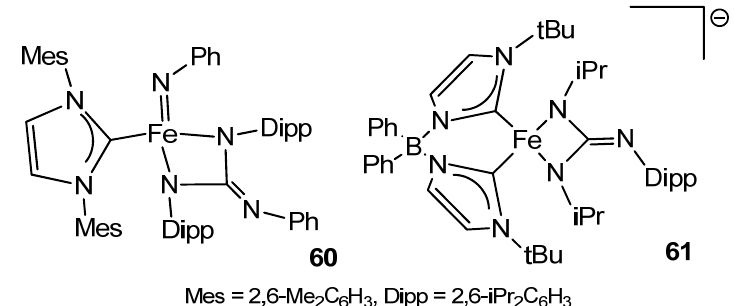
Figure 35. Iron dianionic guanidinato compounds.